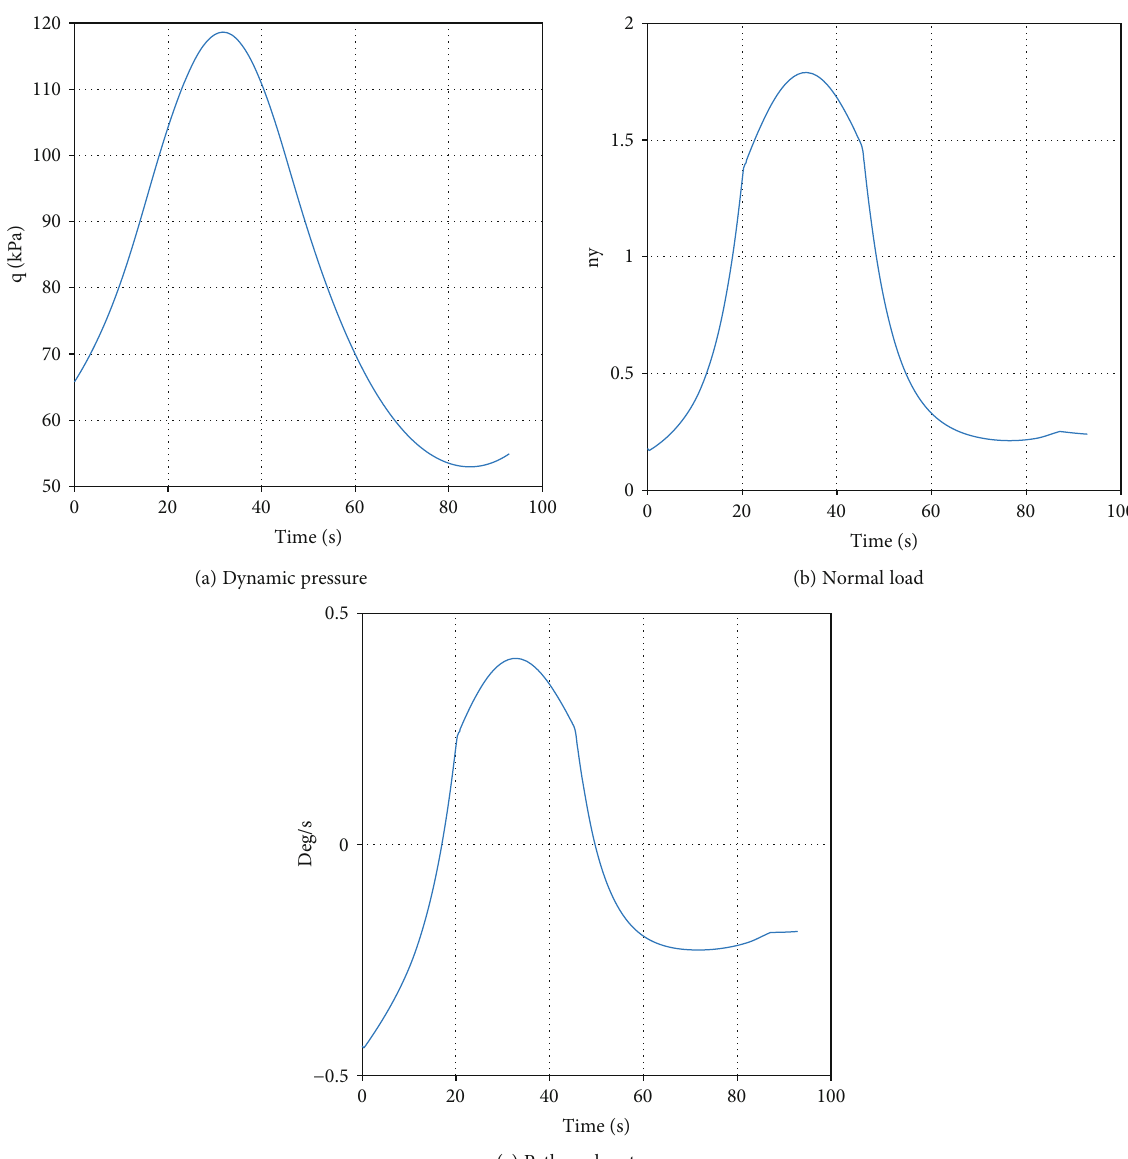
Figure 5: The time history of path